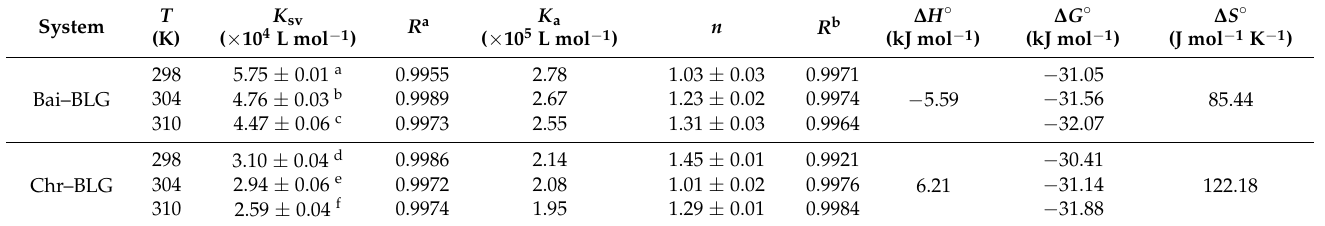
Table 1. Quenching constant ( K SV ), binding constant ( K a ), the number of binding site ( n ), and the thermodynamic parameters of Bai–BLG and Chr–BLG complexes at three different